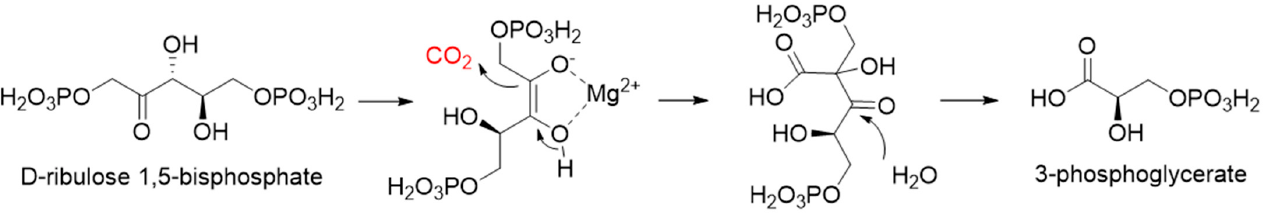
Figure 1. The catalytic mechanism of Rubisco [26].